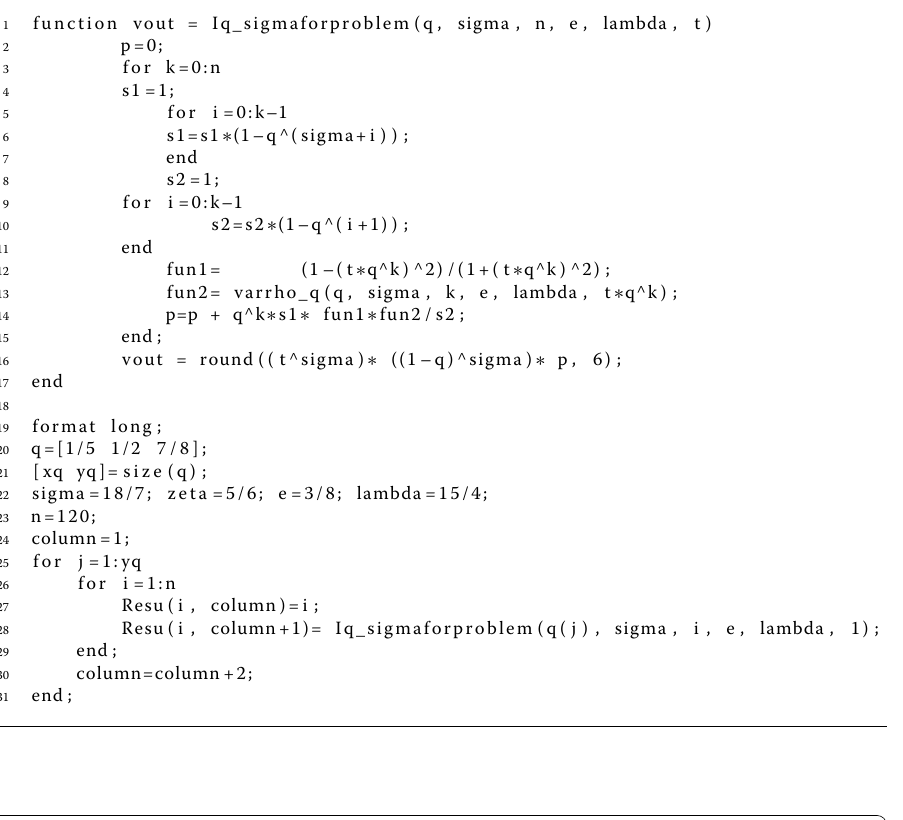
Algorithm 8 MATLAB lines for calculating